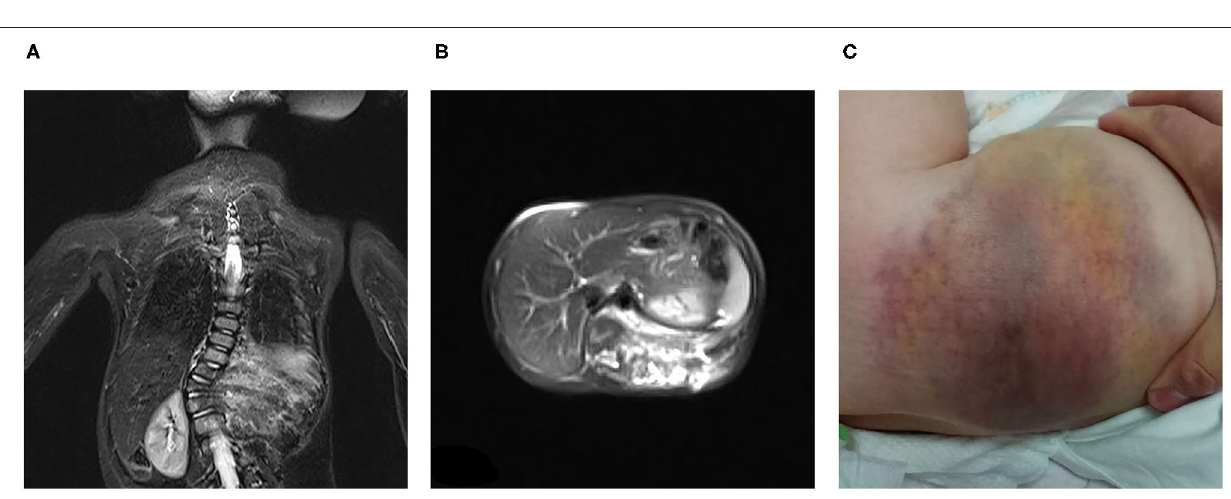
( Figure 3 ). KHE was considered after mediastinal mass